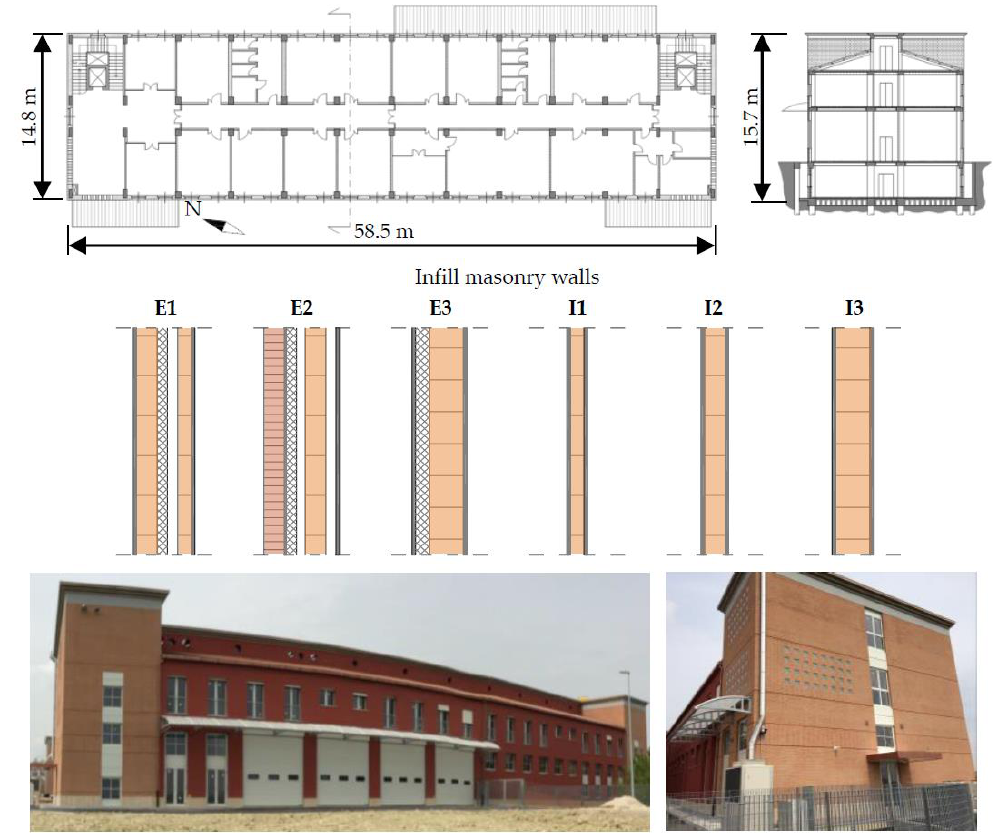
Figure 5. Construction details and pictures of the building case study.